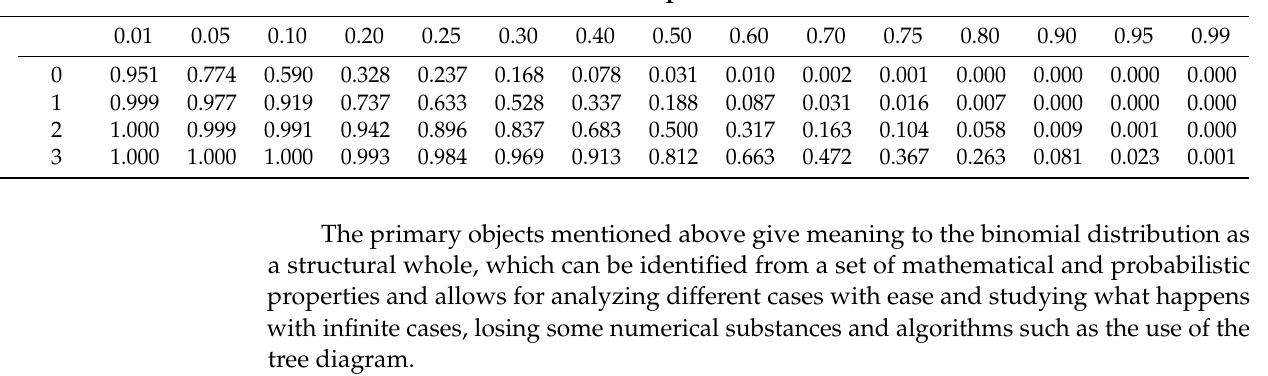
Table 11. Table of cumulative binomial distributions for n = 3 (retrieved from [45]). P